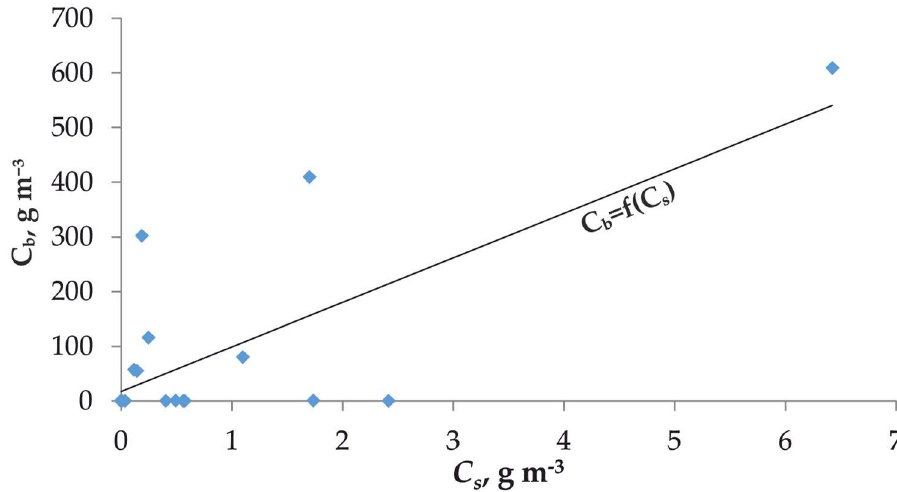
Figure 4. Scatter plot of the concentrations of methane found in the borehole initially after drilling C b , and average concentration of methane in permafrost C s .